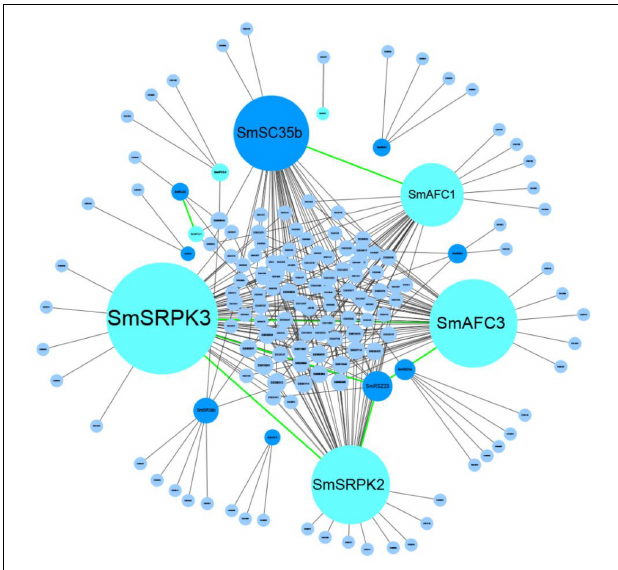
FIGURE 7 | The potential regulatory network of SR splicing factors, phosphokinase, and AS genes. The gray lines represent the correlation between SR proteins or PKs and the active genes. The green lines represent the correlation between PKs and SR proteins or PKs. AS, alternative